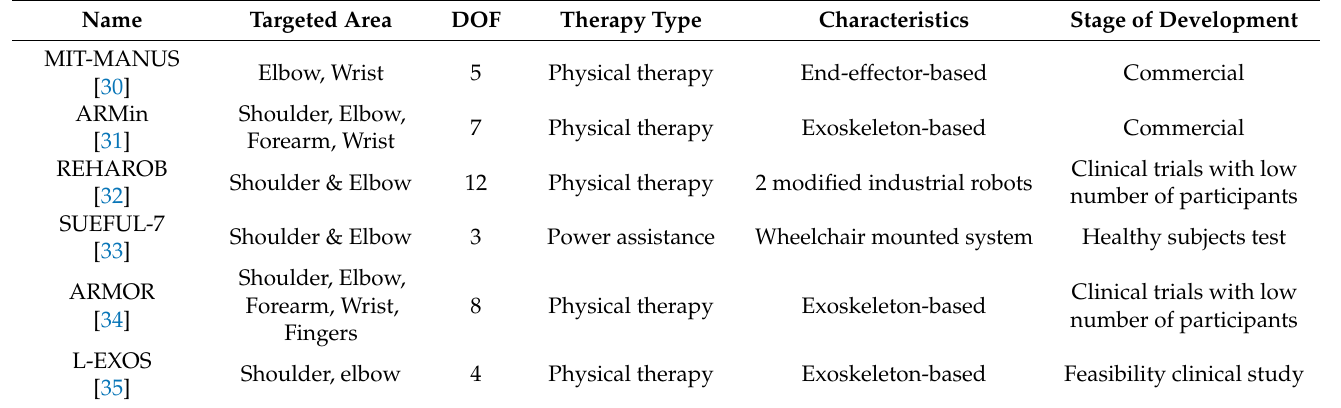
Table 1. Robotic devices for upper limb rehabilitation. DOF: Degree of